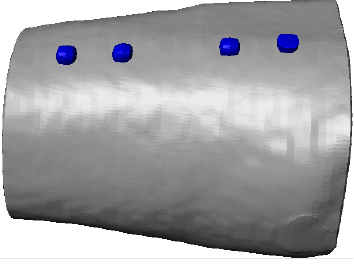
Fig. 18: 3D-view of thigh with electrodes.